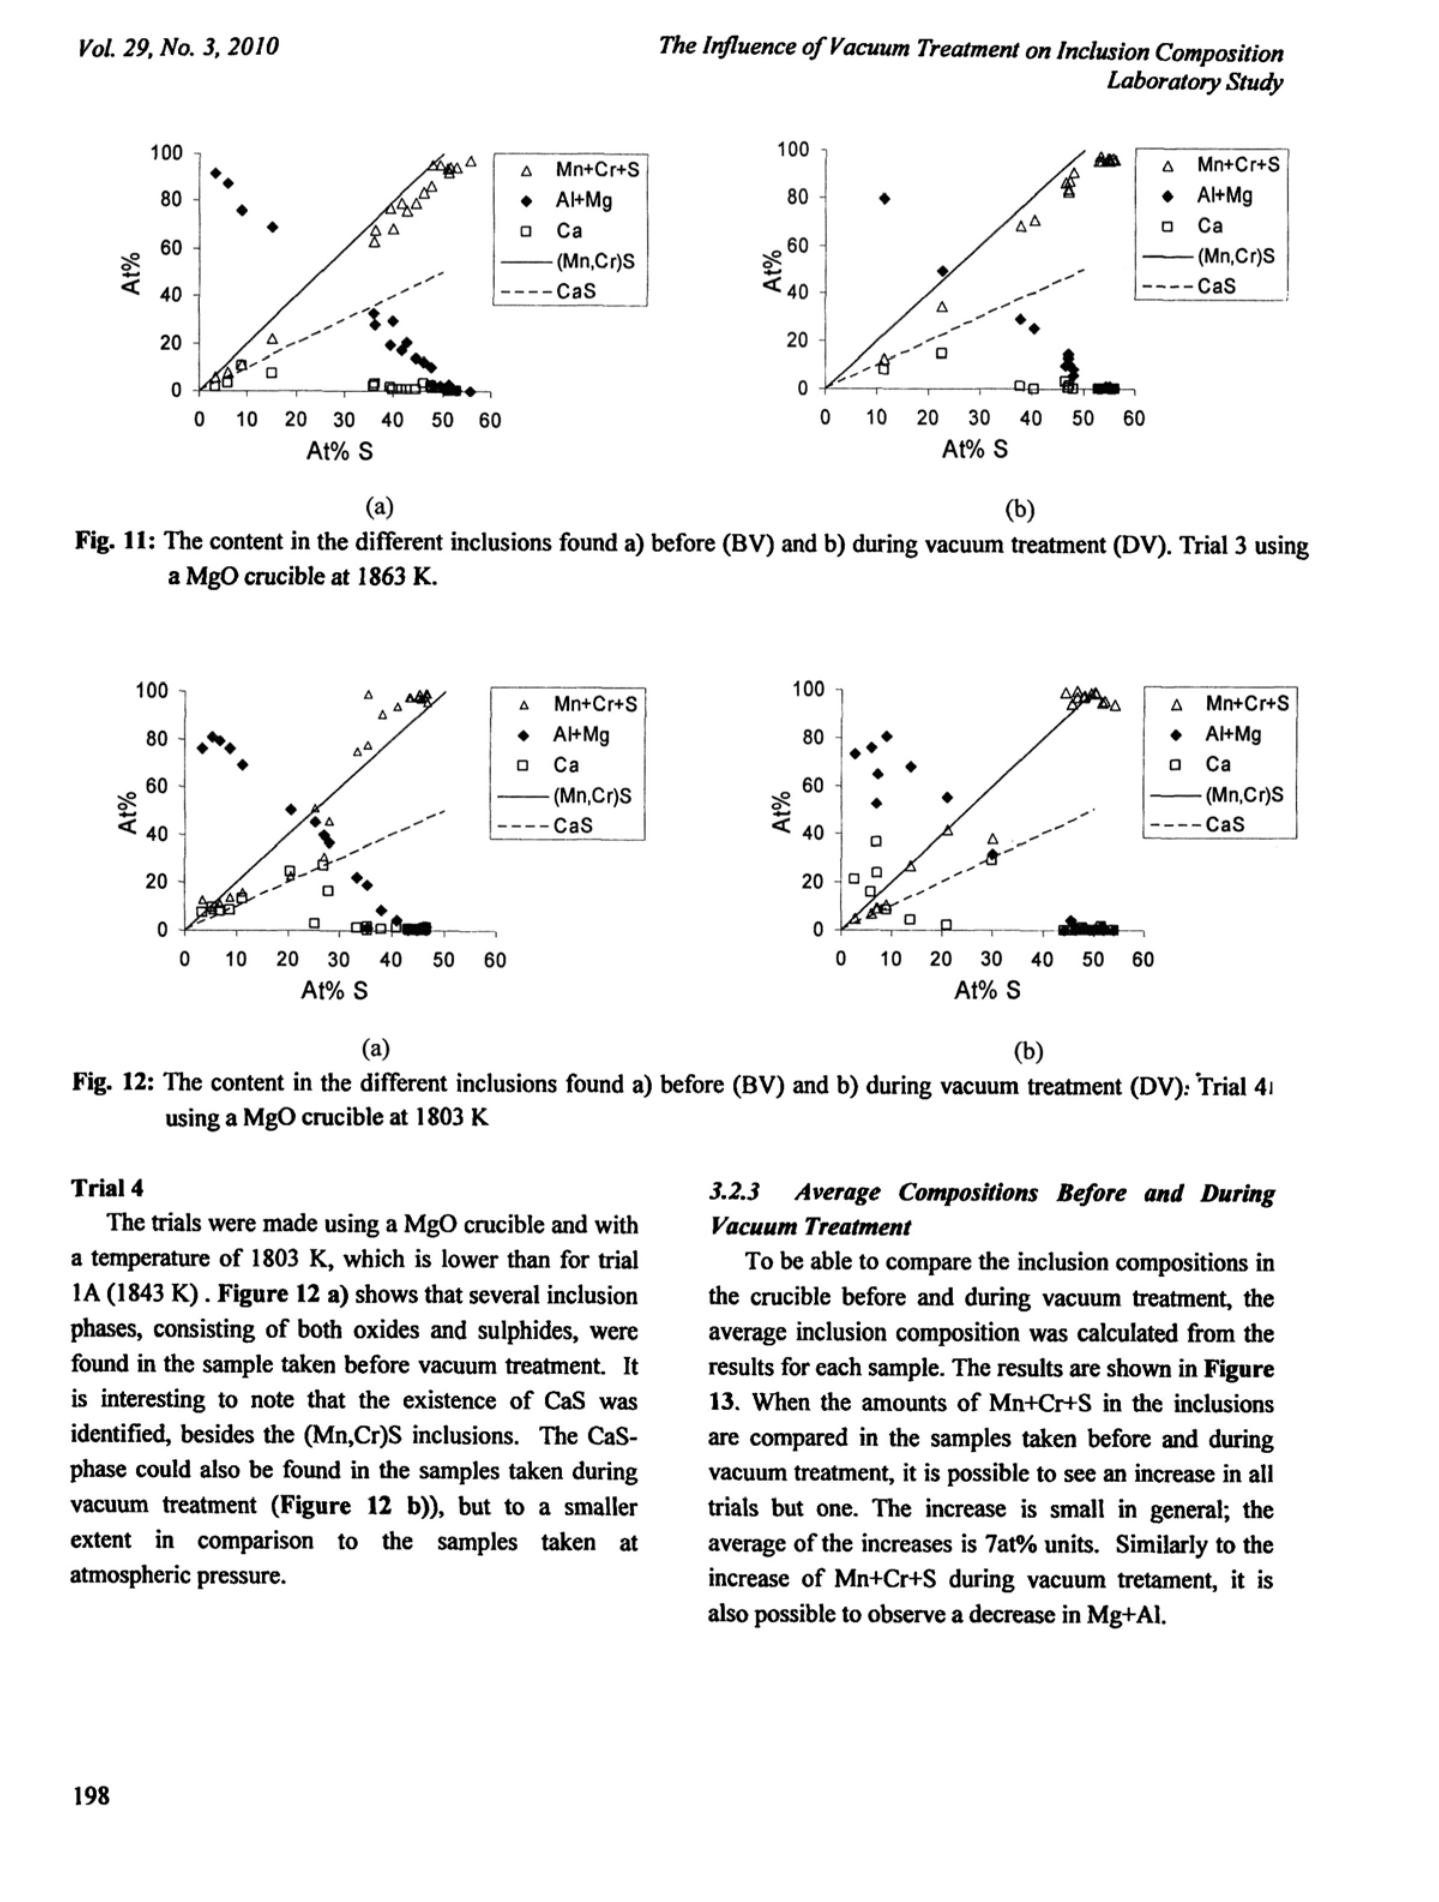
Fig. 12: The content in the different inclusions found a) before (BV) and b) during vacuum treatment (DV): Trial 4i using a MgO crucible at 1803